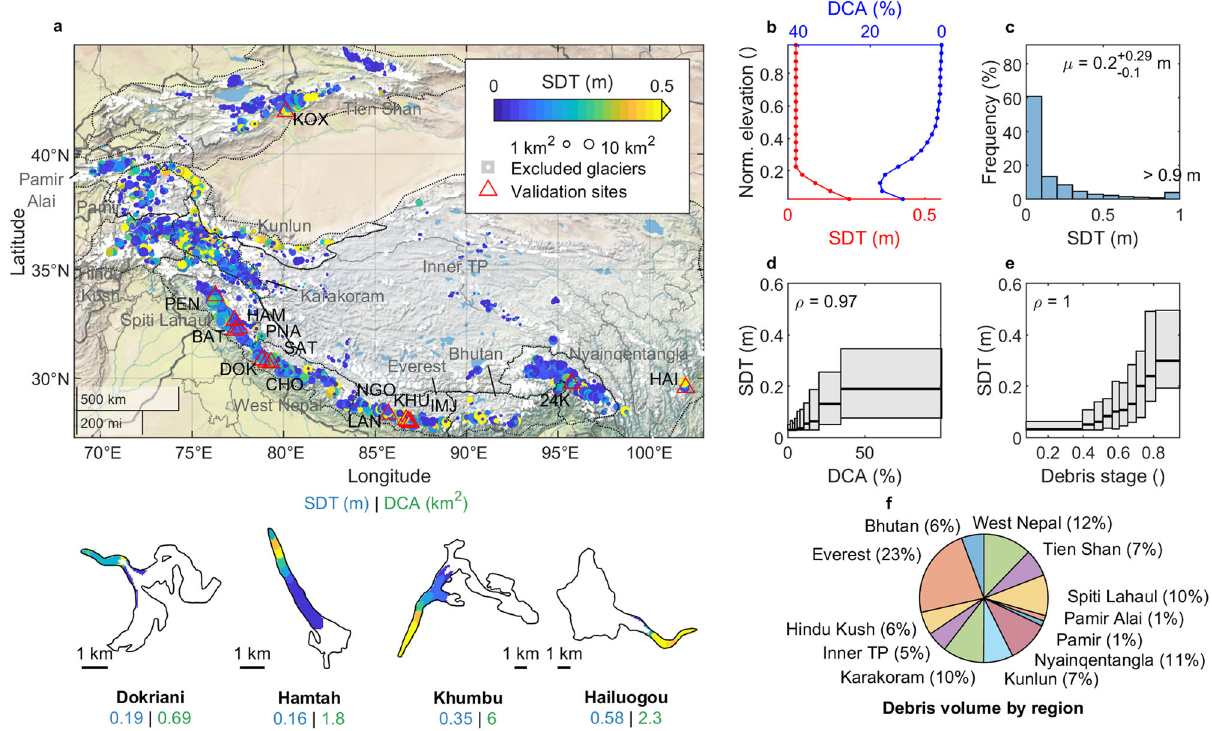
Fig. 1 Supraglacial debris thickness (SDT) and volume in High-Mountain Asia (HMA). a top panel, Glacier-mean debris thickness across High-Mountain Asia, with points scaled by debris-covered area (DCA) and base map from Natural Earth; small panels, distributed debris thickness for selected glaciers. b Median debris thickness (red) and debris-covered area (blue) with respect to normalised glacier elevation. c Debris thickness frequency distribution. d Glacier-mean debris thickness binned by debris-covered area. e Glacier-mean debris thickness binned by debris-cover stage from 1 . f Debris volume by mountain region relative to the total volume of debris on the 4689 study glaciers. Plots with bins show median and interquartile range, where each bin contains one tenth of the data. μ is mean value. Spearman ’ s ρ is calculated for bin centres. Validation sites are Pensilungpa (PEN), Koxkar (KOX),